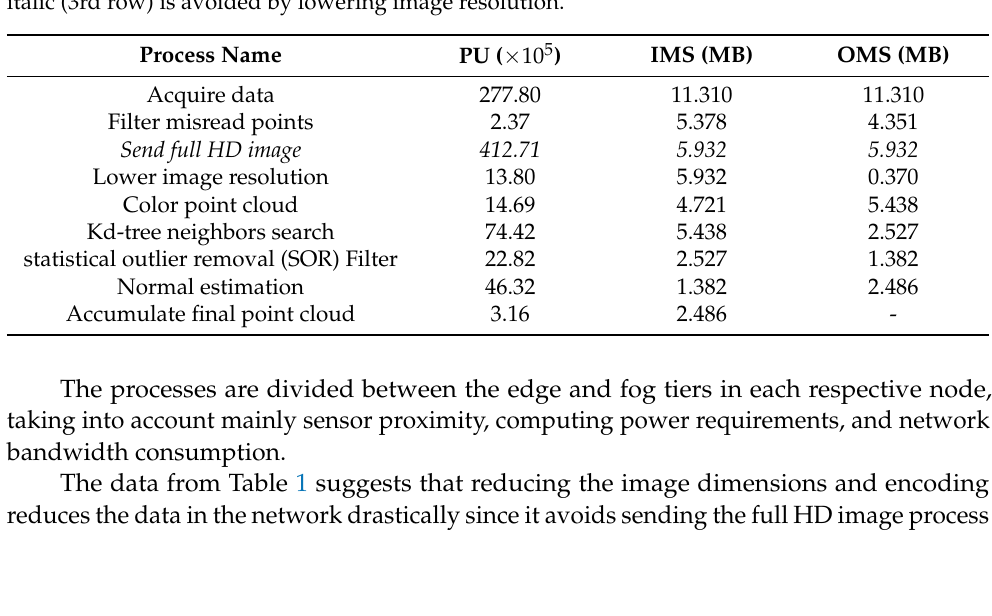
Table 1. Average results for PU, IMS, and OMS for every relevant processing step. The process in italic (3rd row) is avoided by lowering image